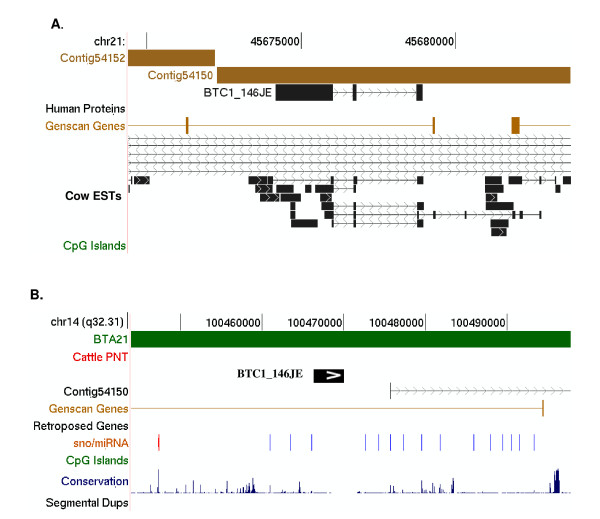
Genomic context of BTC1_146JE. Top panel (A). A modified image from the UCSC cow genome browser (March 2005, Btau_2.0) showing BTC1_146JE aligned to the cattle genome (Contig54150) [GenBank:AAFC02053608]. Cow ESTs are shown in a scaled "squish" mode to conserve space due to the large number of ESTs aligning in the region. Bottom panel (B). Anchoring of BTC1_146JE, represented as a block arrow, to HSA14q32.31 (May 2004, Hg17). BTC1_146JE was anchored on the basis of its complete alignment to contig54150 and similarity of flanking sequence in the contig to the human genome shown as a vertical line along the track. This region is syntenic to a segment of BTA21 (shown as a separate track), consistent with RH mapping data [23]. UCSC Genome Browser tracks for known human proteins, Genscan genes, sno/miRNA, conserved sequences, and segmental duplication are unmodified.